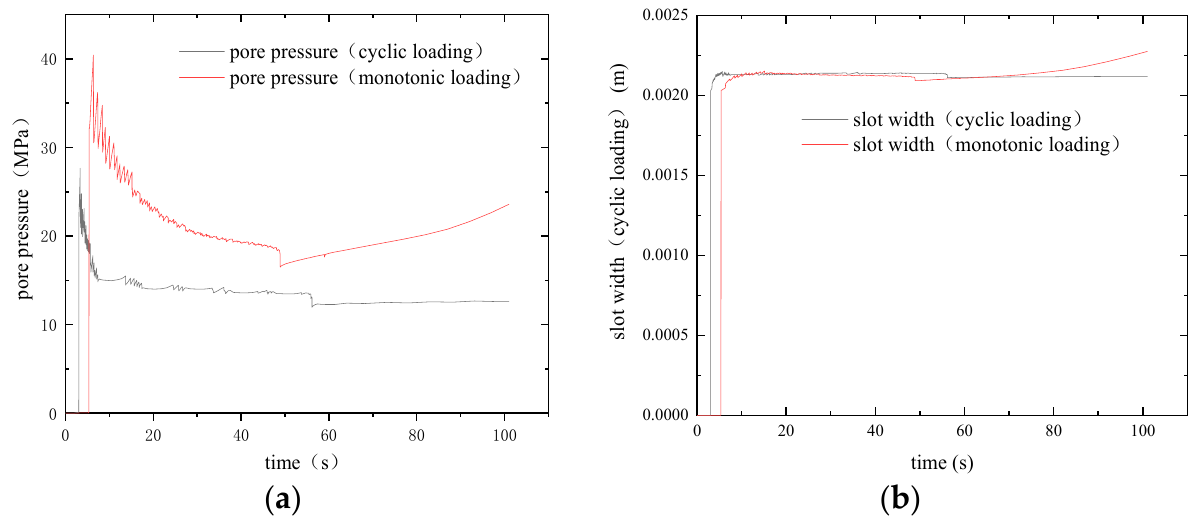
Figure 5. Changes in pore pressure and fracture width in borehole center. ( a ) Pore pressure; ( b ) Slot width.